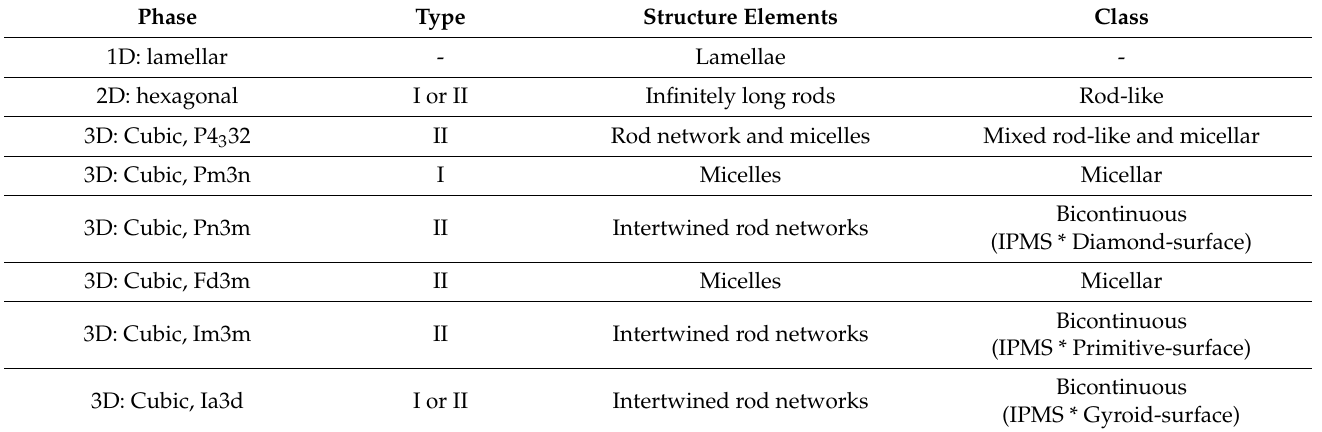
Table 2. Structural properties of some lipid